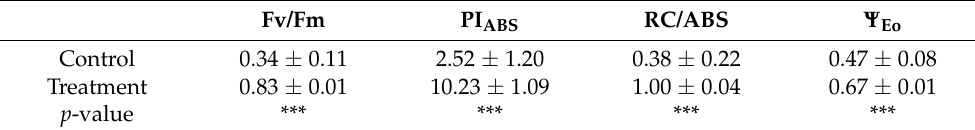
Table 2. Chl a fluorescence parameters of control plants and plants treated with Archer ® Eclipse.